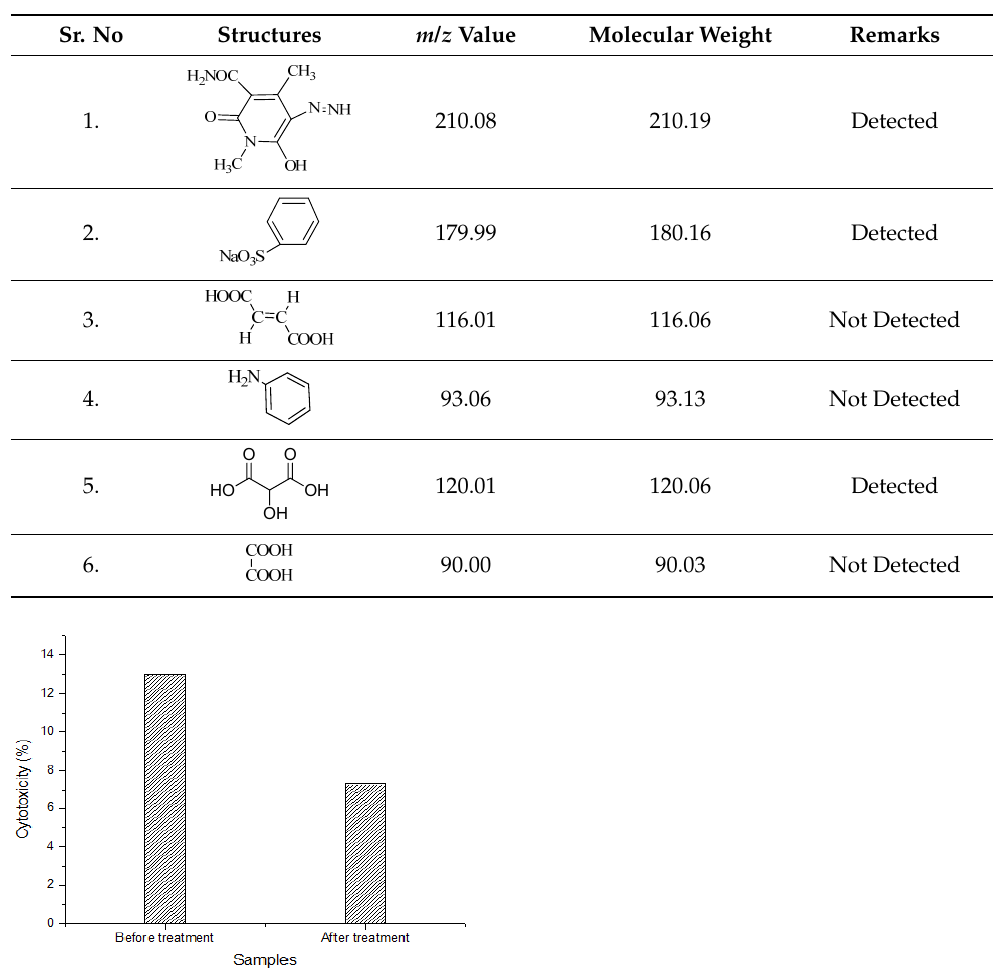
Figure 11. Cytotoxicity analysis of Reactive Yellow 160A before and after treatment (TiO 2 = 450 mg/L, RY ‐ 160A = 30 mg/L, H 2 O 2 = 0.8 mL, irradiation time = 120 min).